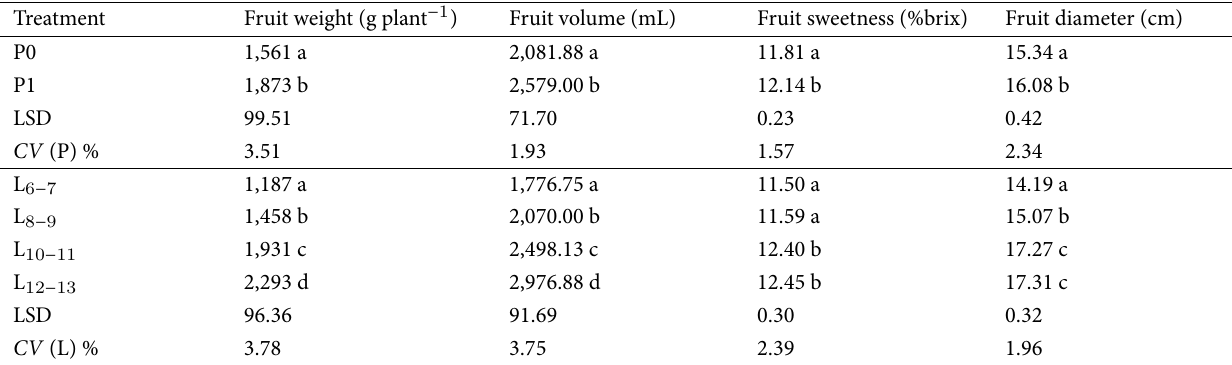
Table 3 Effects of bud trimming or fruit position arrangement on fruit weight, fruit volume, fruit sweetness, and fruit diameter at harvest at 70